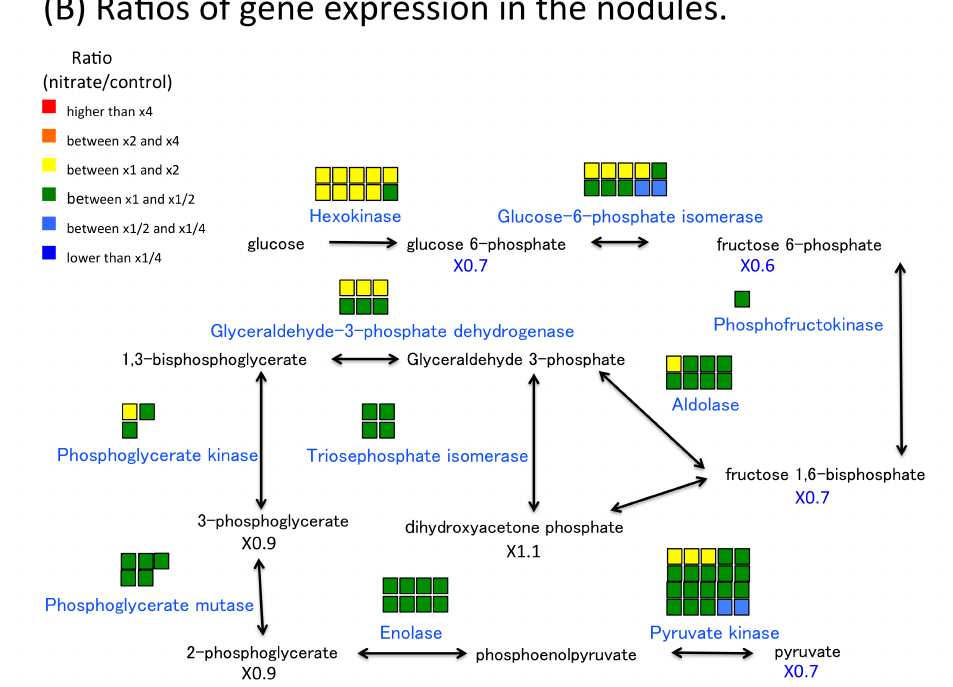
Figure 5. Ratios of gene expression and metabolite concentrations related to glycolysis in roots and root nodules after a 24-h 5-mM nitrate treatment. ( A ) Ratios of gene expression and metabolite concentrations in the roots. ( B ) Ratios of gene expression and metabolite concentrations in the nodules. The model shows the metabolic map of glycolysis in the root or nodule cells. The color of squares above enzyme name and the number under the compound abbreviation indicate the same as Figure